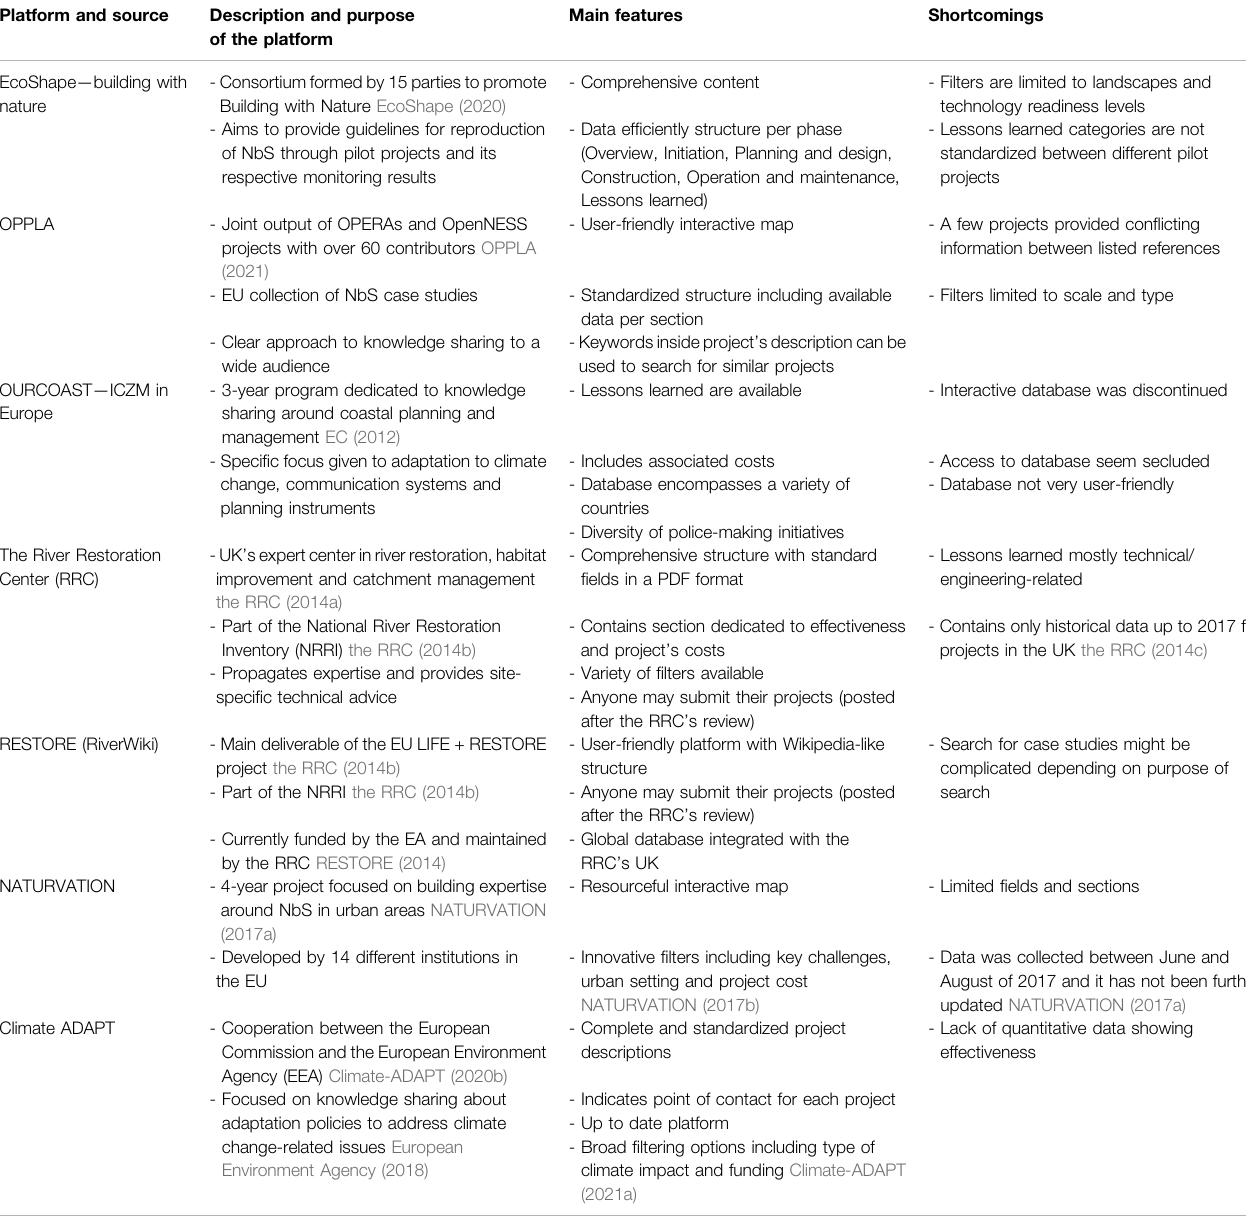
TABLE 1 | Characteristics of the main NbS platforms reviewed in this study, including a short description and purpose of each database and the main features and shortcomings identi fi ed, pertinent to this